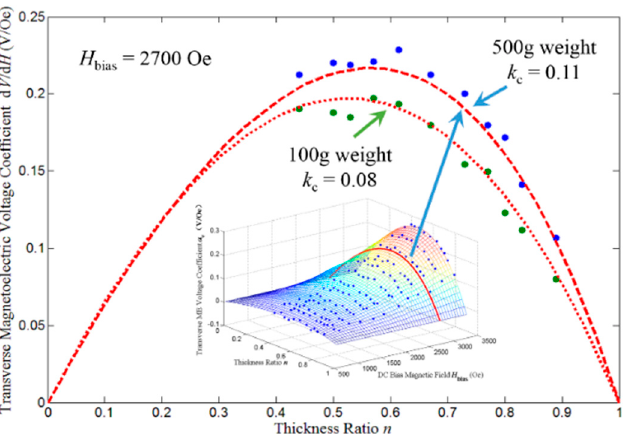
Figure 11. The theoretical and measured transverse ME voltage coefficient as a function of the thickness ratio under 2700 Oe DC bias magnetic field. The scattered blue points represent the measured data under 500 g pre-mechanical load, the scattered green points represent the measured data under 100 g pre-mechanical load, the red dash line represents the theoretical curve for k c = 0.11 and the red dotted line represents the theoretical curve for k c = 0.08.